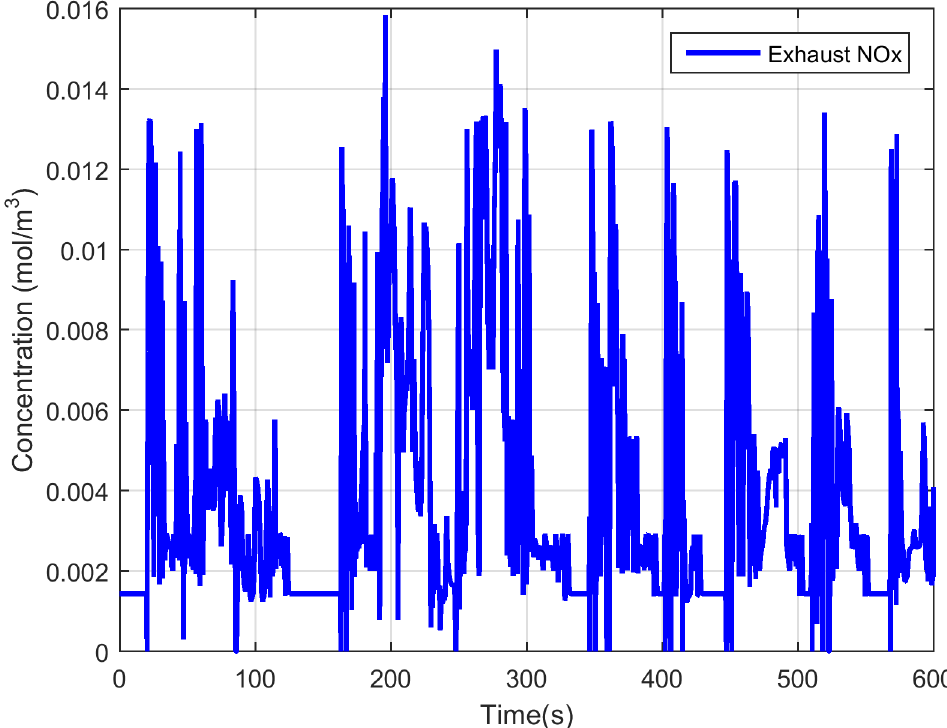
Fig 4. The engine-out NOx concentration during the FTP-75 test cycle simulation.